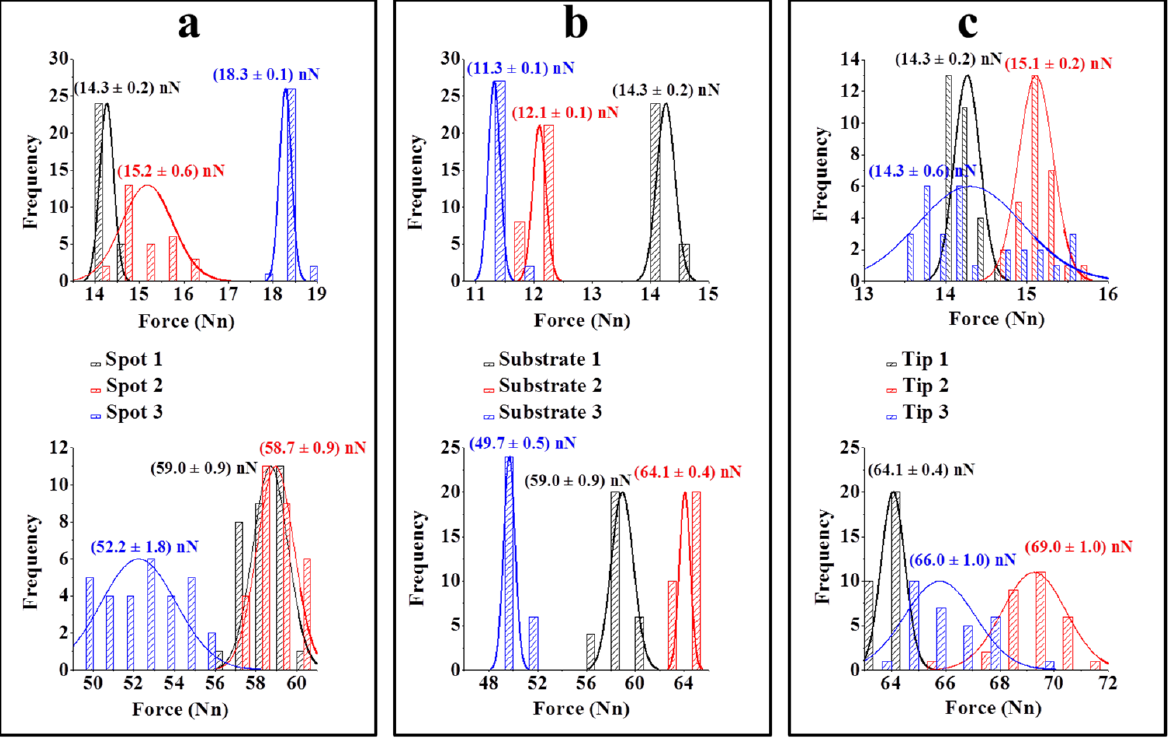
Figure 6. Comparative graphs of the force curve measurements taken using unfunctionalised (above) and functionalised (below) AFM tips ( a ) at three different points on the same substrate, ( b ) on three substrates with herbicides (triplicate), and ( c ) using three different tips (silicon